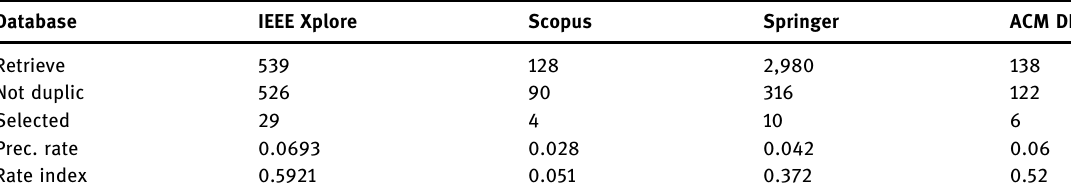
Table 1: Retrieved and non - duplicated and selected primary studies